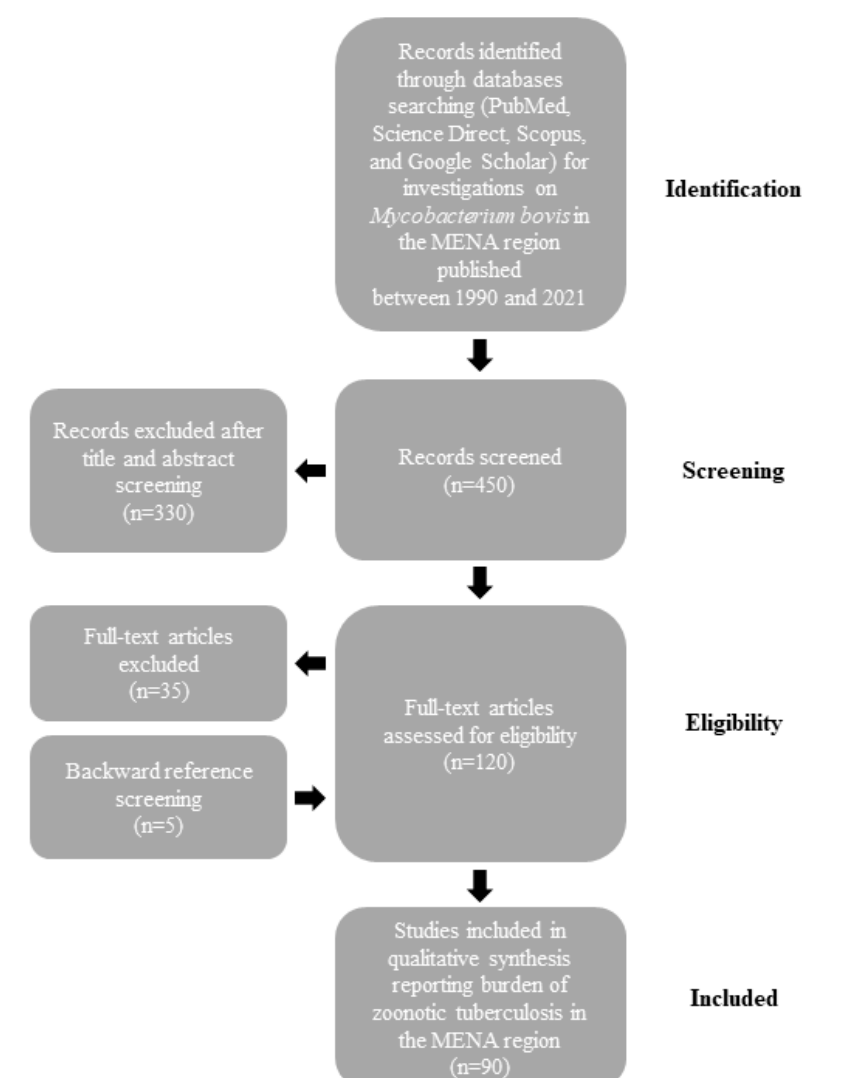
Figure 1. Flow diagram describing paper selection and inclusion/exclusion process for the review according to PRISMA guidelines.